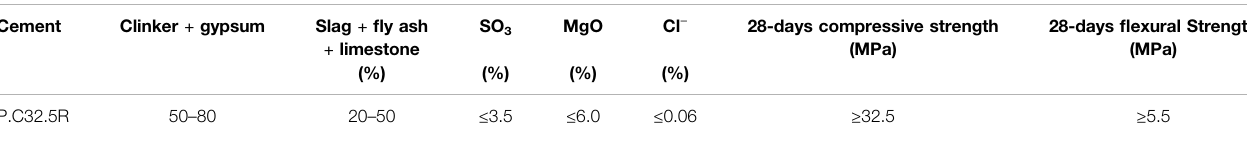
TABLE 1 | Property parameters of